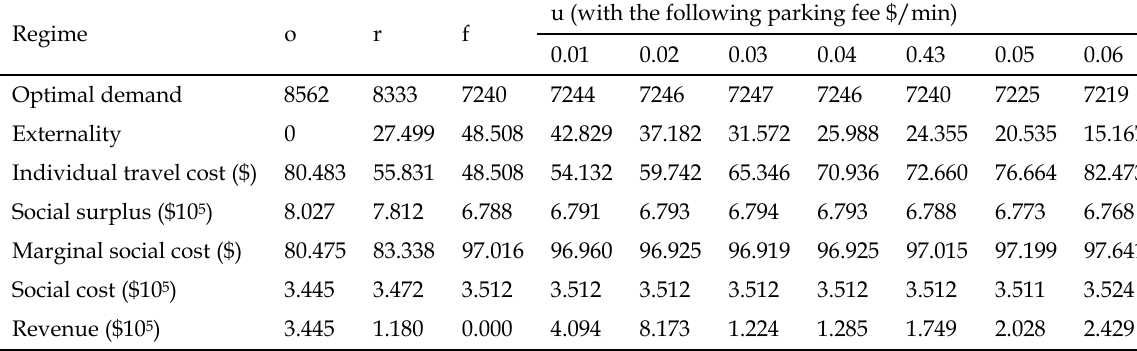
Table 2. Main numerical results in various regimes in the case of elastic demand